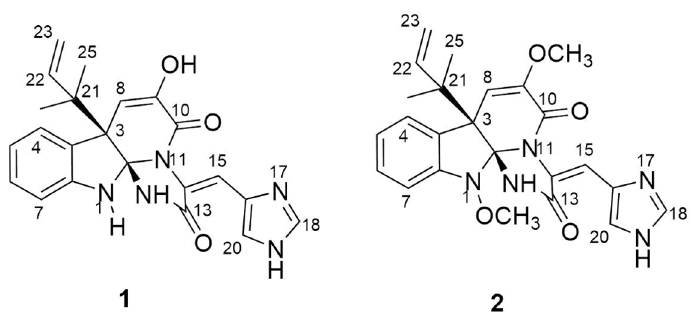
Figure 2. Chemical structure of compounds 1 and 2 .